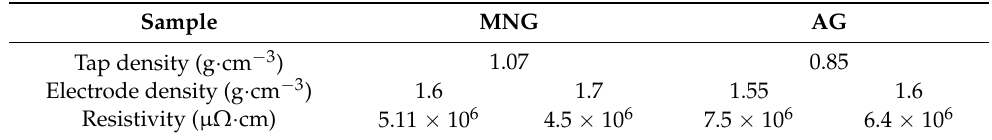
Table 1. Tap density of MNG and AG, and sheet resistance of MNG and AG electrodes with different electrode densities.